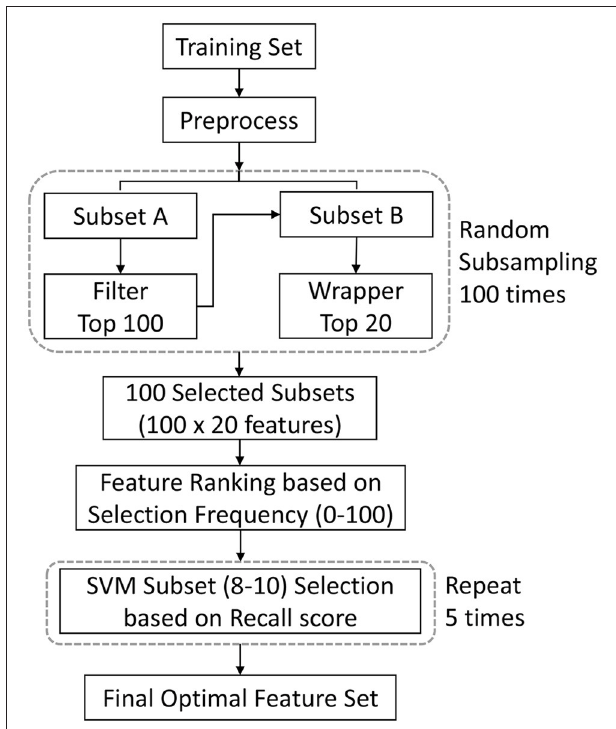
FIGURE 1 | Illustration of the feature selection procedure. This procedure integrate filter and wrapper methods within the subsampling procedure. The optimal features consisted of the features which were most frequently selected in all the subsamples of data. The final optimal feature set was determined by validating classification performance on the training data. We used feature ranking with ANOVA F-value as the filtering process, and the recursive feature elimination algorithm as the wrapping process. A single experiment within a cross-validation (CV) iteration is depicted. SVM = support vector